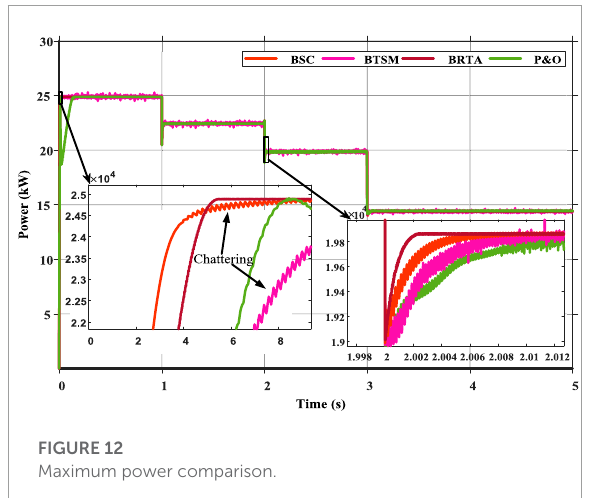
FIGURE 12 Maximum power